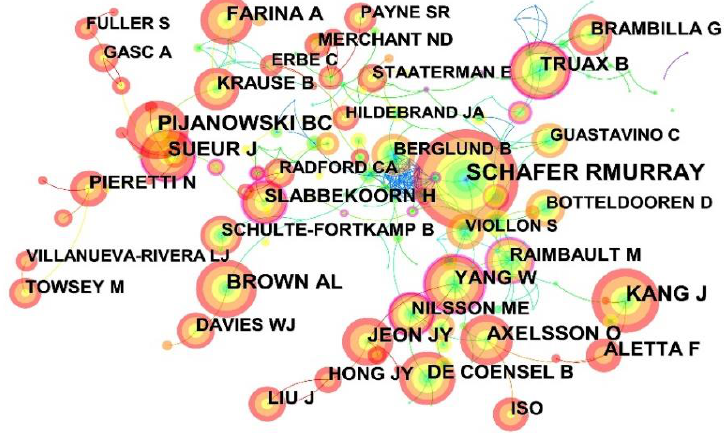
Figure 6. A network map showing authors co-citation in soundscape research. Table 4. Top 10 most-cited authors in the field of soundscape.